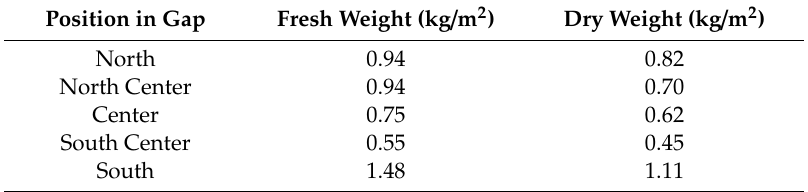
Table 1. Fine fuel load distribution across positions in the harvest created gap in a slash pine